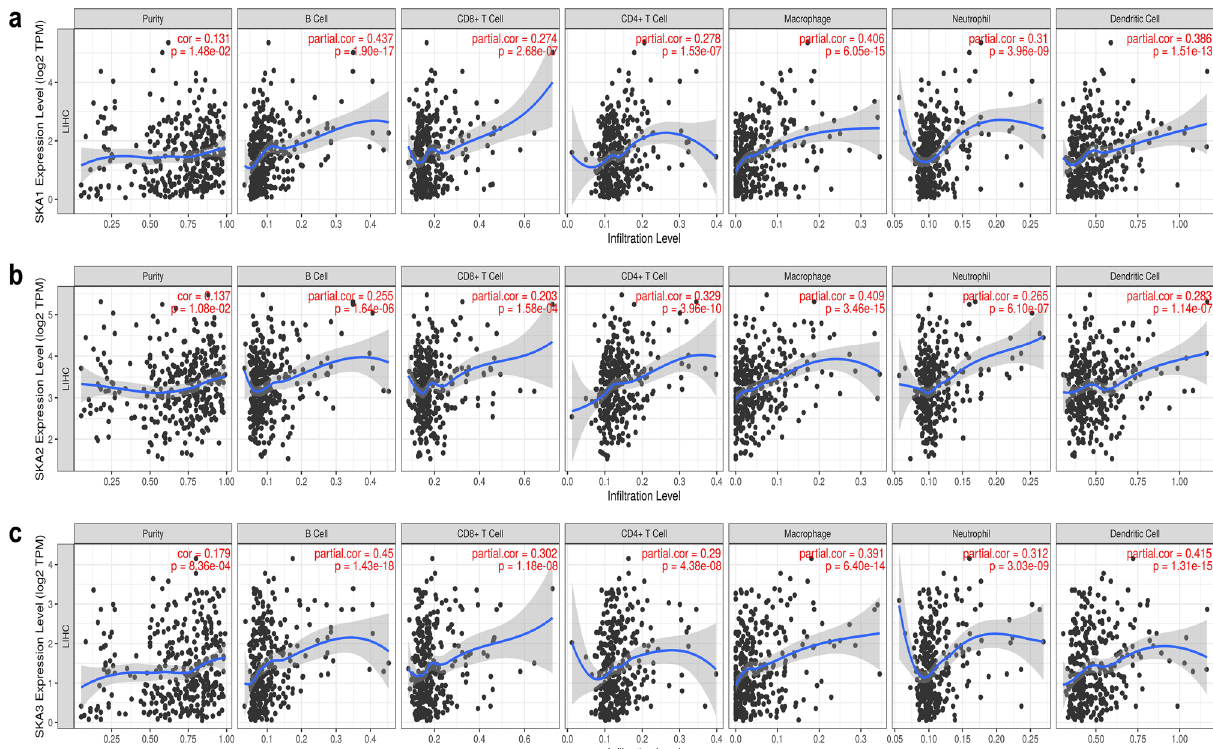
Figure 8. The relationship between SKAs and tumor immunological features of HCC patients. ( a ) The relationship between SKA1 and immune infiltrating cells. ( b ) The relationship between SKA2 and immune infiltrating cells. ( c ) The relationship between SKA3 and immune infiltrating